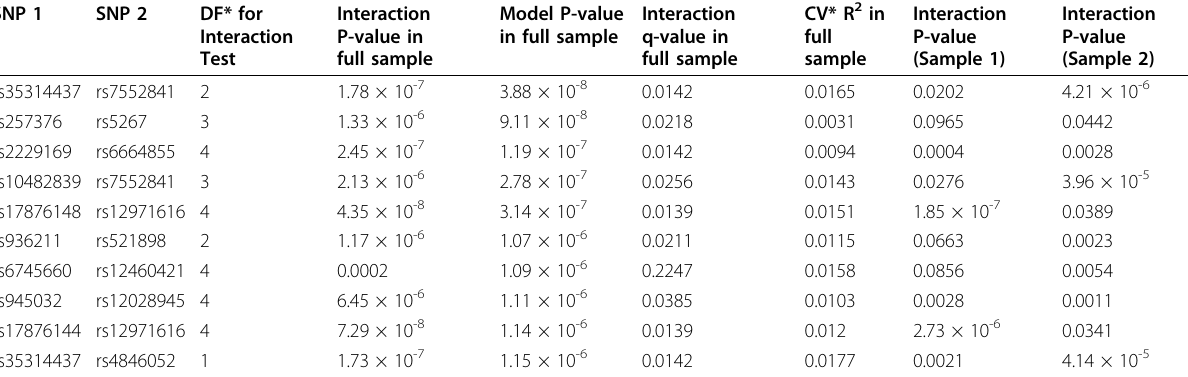
Table 3 Detailed results for the ten most significant SNP-SNP interaction models